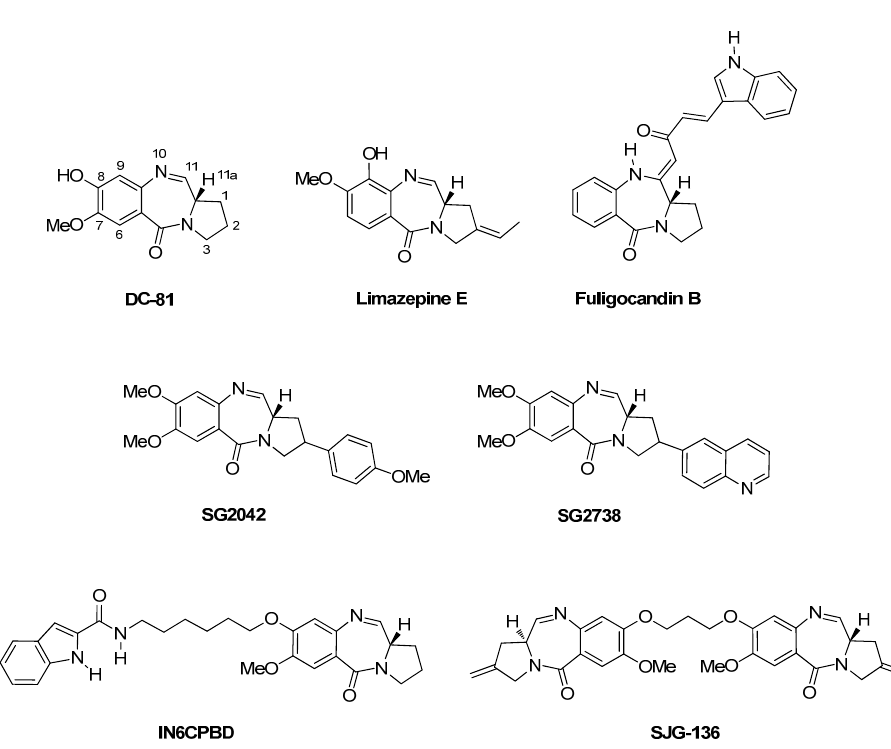
Figure 2. DC-81, Limazepine E and Fuligocandin B are natural products, SG2042 and SG2738 are PBD monomers, IN6CPBD is a PBD conjugate and SJG-136 is a PBD dimer.